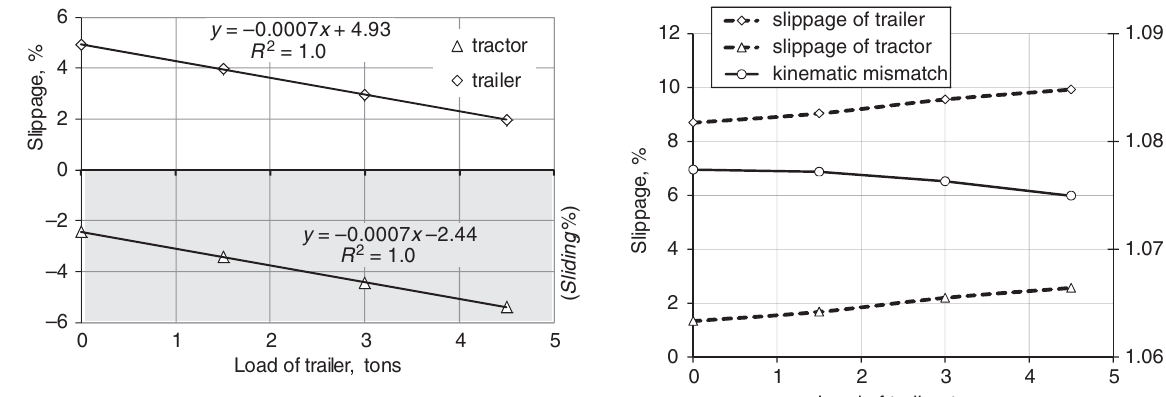
Fig. 5. The dependences of driving wheels’ slippage on the load carried by trailer, while the trailer’s both driving axles Fig. 7. The dependences of driving wheels’ slippage and are activated and driving is executed on a plowed soil kinematic mismatch coefficient on the load carried in the trailer, when tractor’s rear and trailer’s front driving axles are enabled and driving is executed on the plowed y = –0.63 x + 4.41 R 2 = 0.998